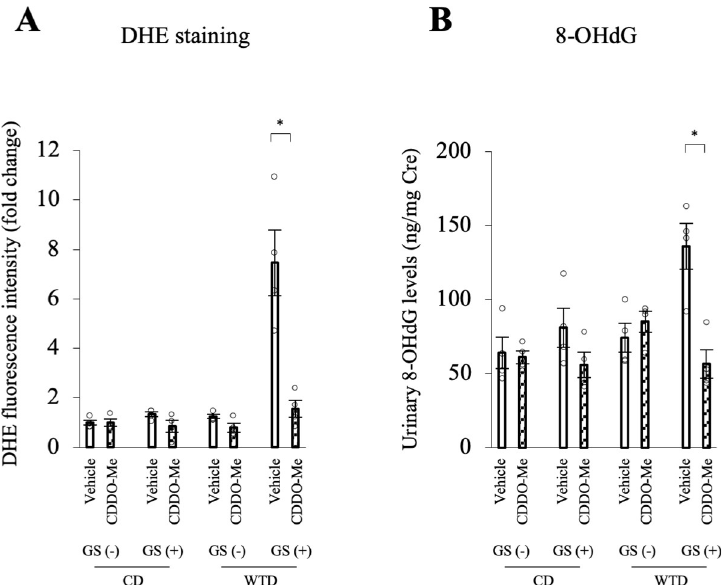
Fig 10. CDDO-Me (3 mg/kg) suppresses local and systemic oxidative stress in the WTD-GS (+) group. The thoracic aorta and urinary sample were collected 2 hours after glucose administration. A: DHE fluorescence intensity in the thoracic aorta. B: Urinary 8-OHdG levels. � P < 0.05, Bonferroni correction. The data are presented as the means ± SEM. N = 4 rats per group. CD, control diet; WTD, Western-type diet; GS, glucose